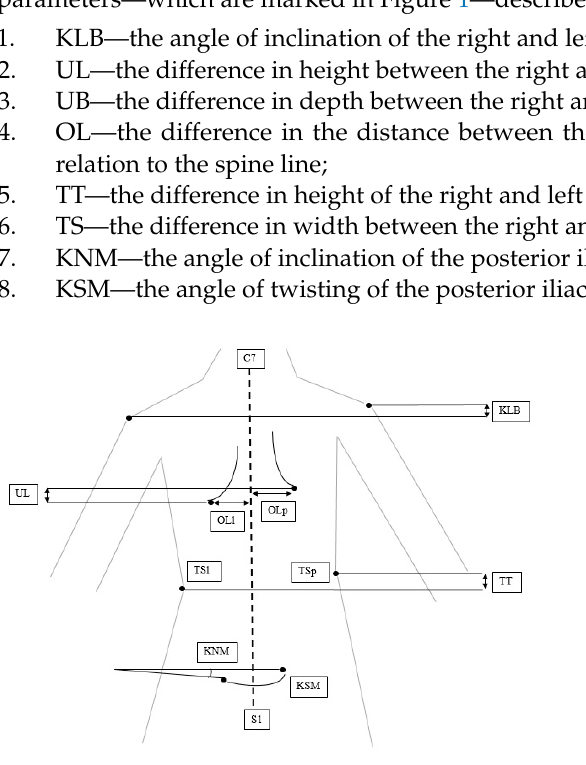
Figure 1. Listed body posture evaluation parameters. Source: own material.